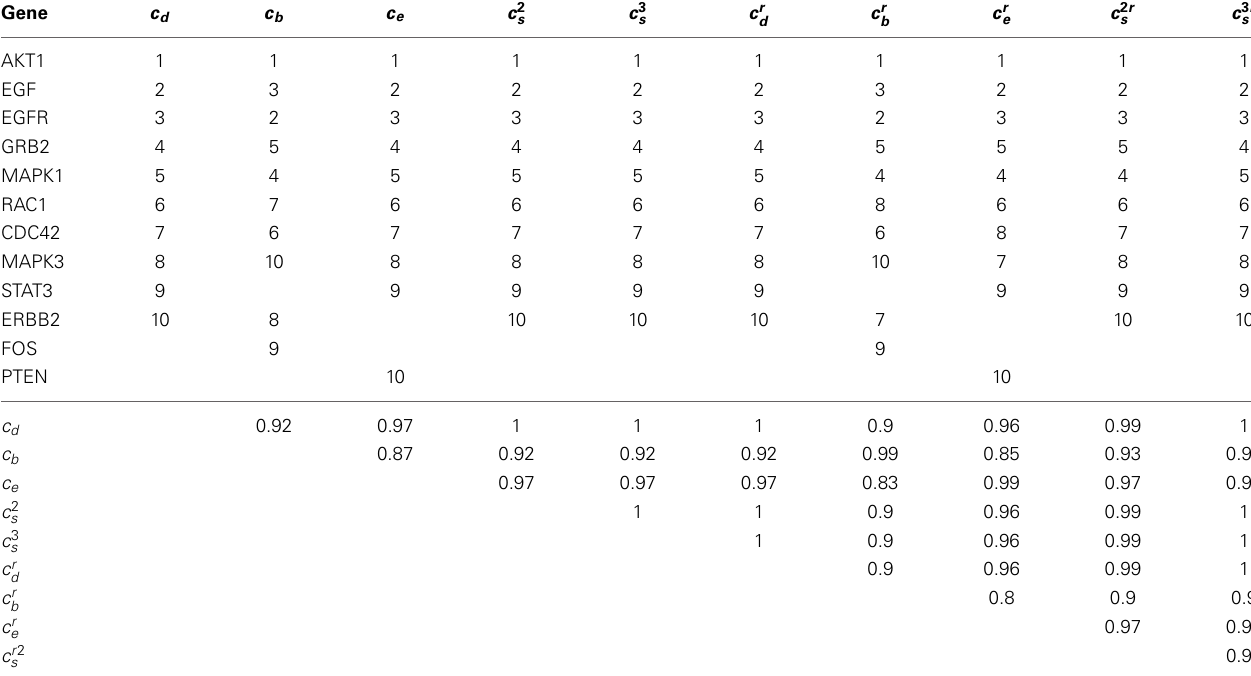
Table 1 | Top ranking genes in EGFR PPI subnetwork by various centrality measures. Gene c